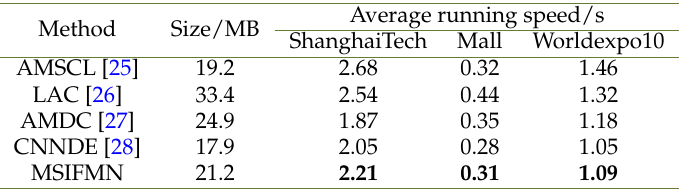
Table 5. Complexity comparison with different